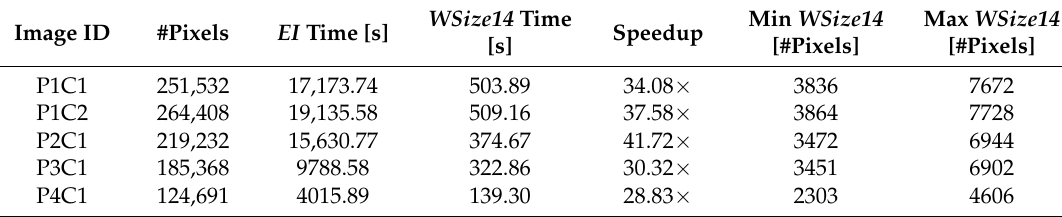
Table 2. Execution times of the serial code considering as search space both the entire image ( EI Time) and a window with 14 rows ( WSize14